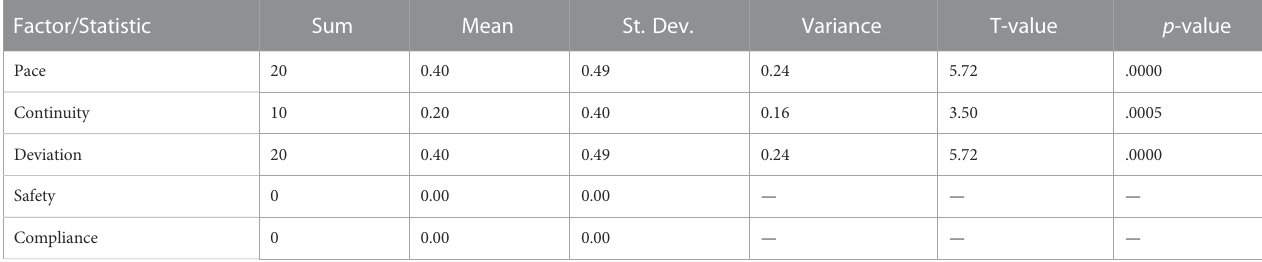
TABLE 5 Descriptive statistics of the performance factor in scenario 1: